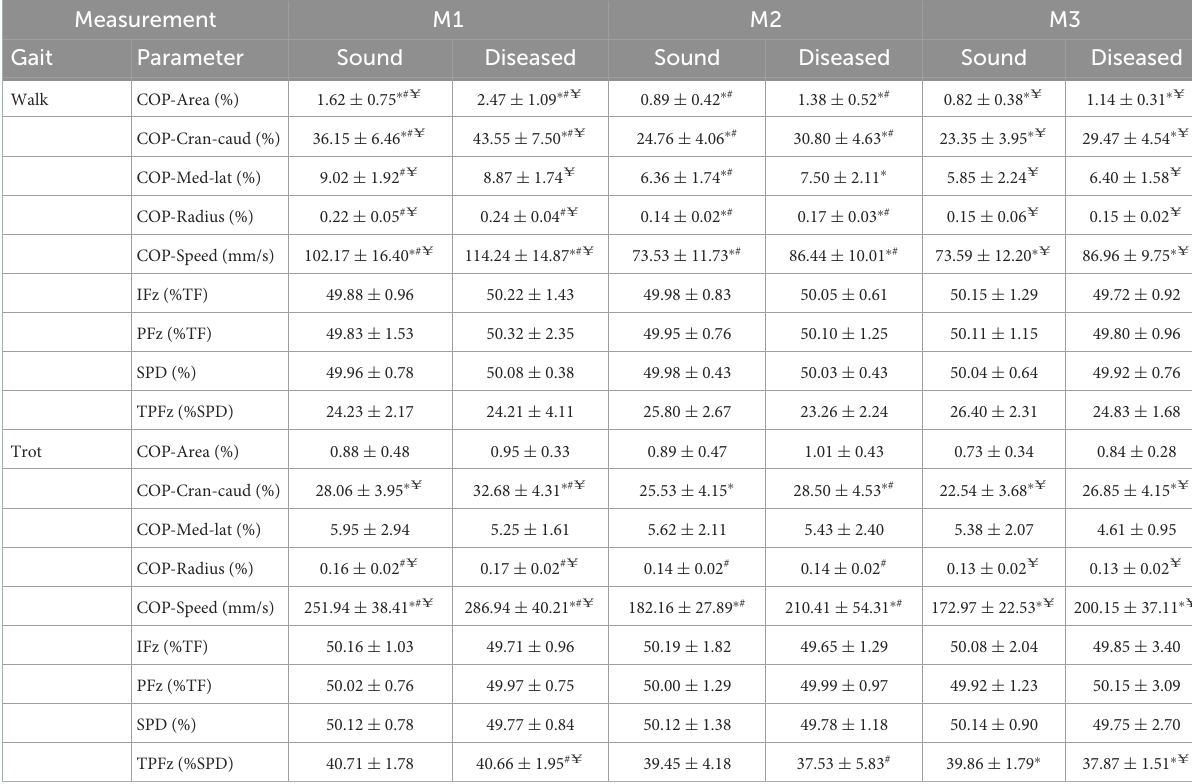
TABLE 5 Descriptive statistics (mean ± SD) for walking and trotting Golden Retrievers ( n = 17) at three measurement points (M1 = 4 months, M2 = 8 months, and M3 = 12 months of age) in sound and diseased limb groups.